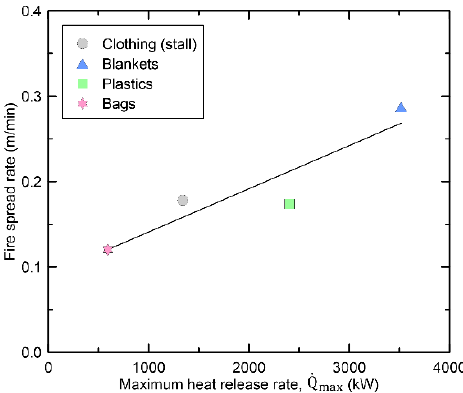
Figure 9. Relationship between the maximum heat release rate and horizontal fire spread rate.